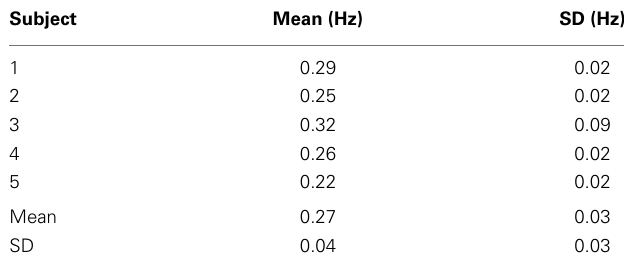
Table 2 | High-frequency cutoff of low-frequency resting-state signal fluctuations in healthy controls.